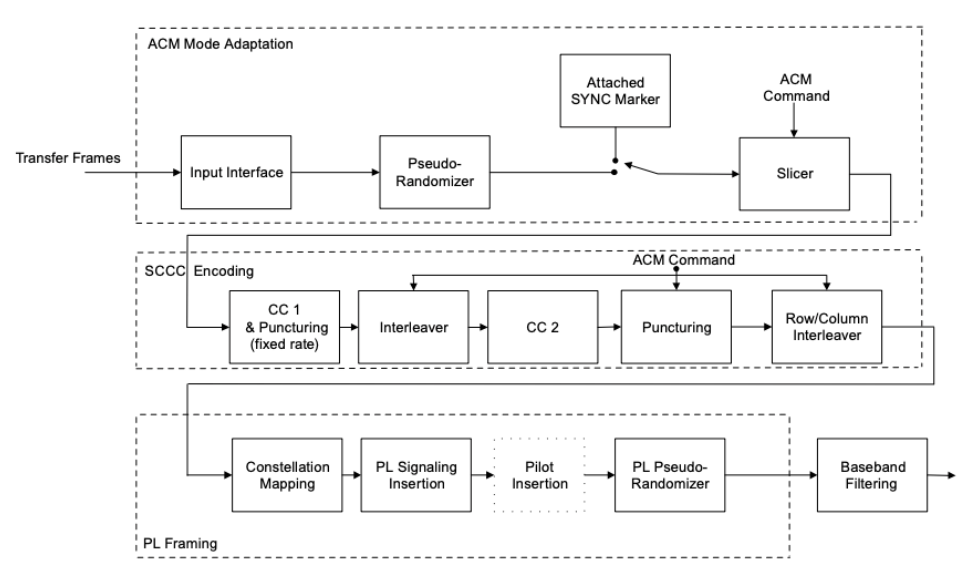
Figure 1. Functional block diagram.